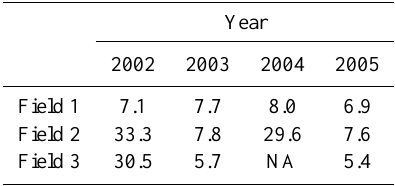
Table 4. Statistical metrics comparing daily measured and modeled fluxes using two-thirds of the fields/years for validation. Energy